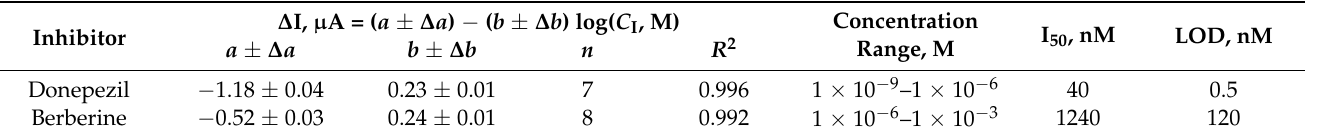
Table 1. Analytical characteristics of donepezil and berberine determination with the flow-through AChE biosensor.